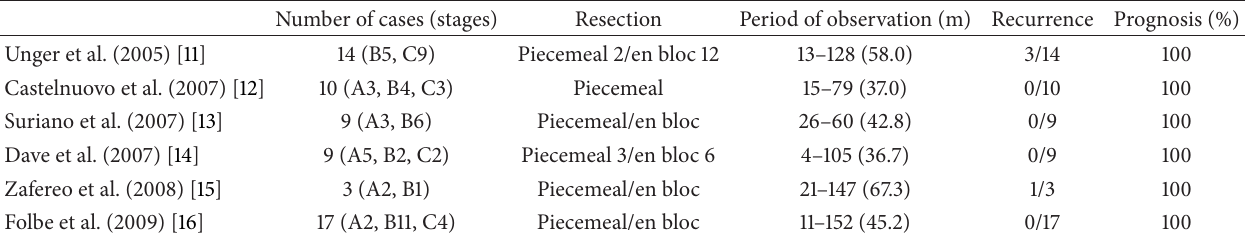
Number of cases (stages)